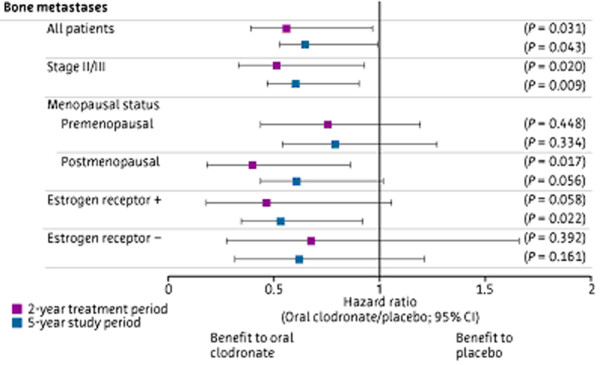
Hazard ratios and 95% confidence intervals (CI) for the incidence of bone metastases in patient subgroups.